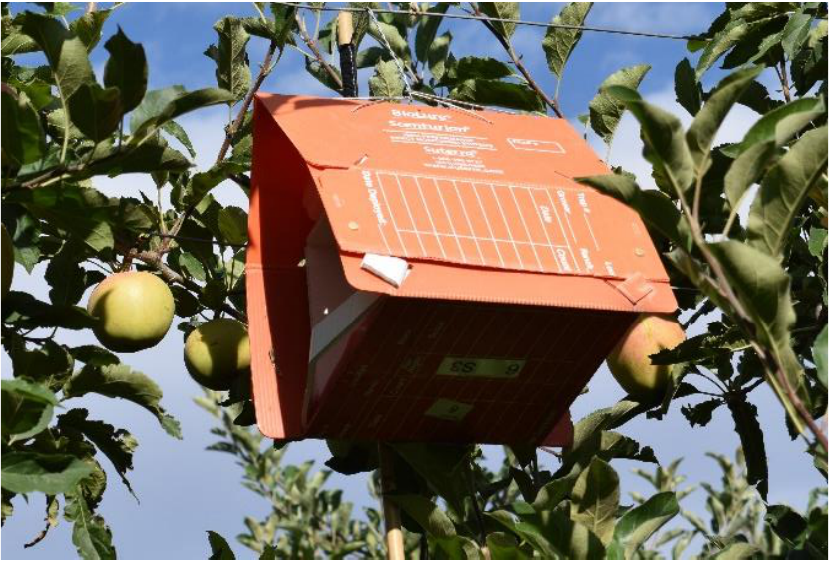
Figure 4. Imaging system plug-in retrofitted in a delta trap installed in apple canopy.